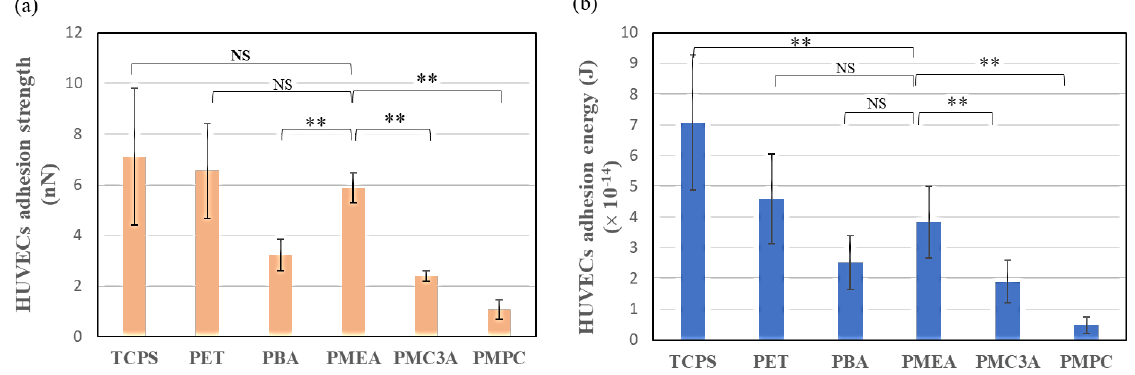
Figure 4. ( a ) HUVECs adhesion strength and ( b ) adhesion energy on various polymer substrates.